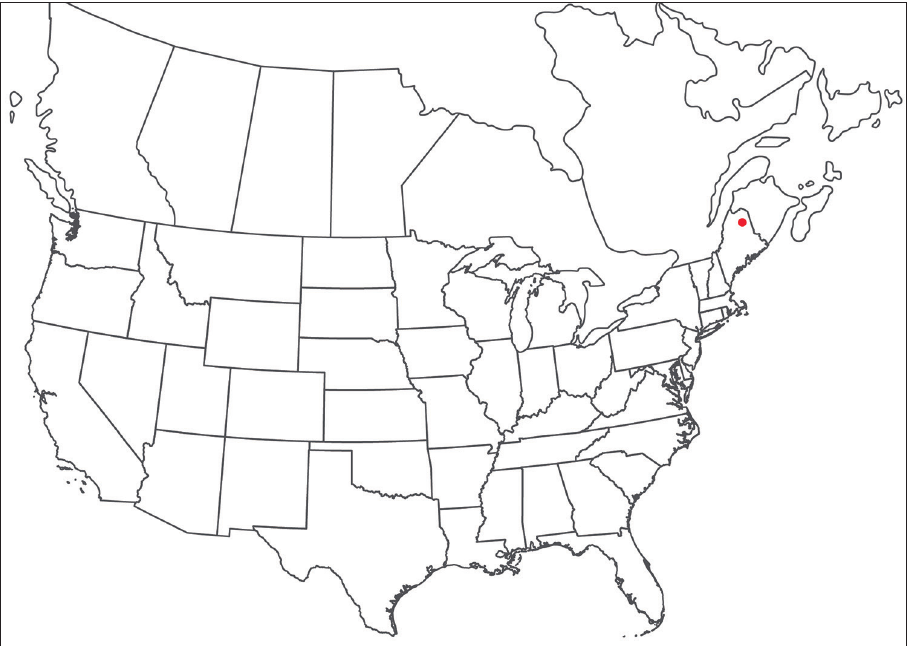
Figure 152. Torrenticola mohawk sp. n.